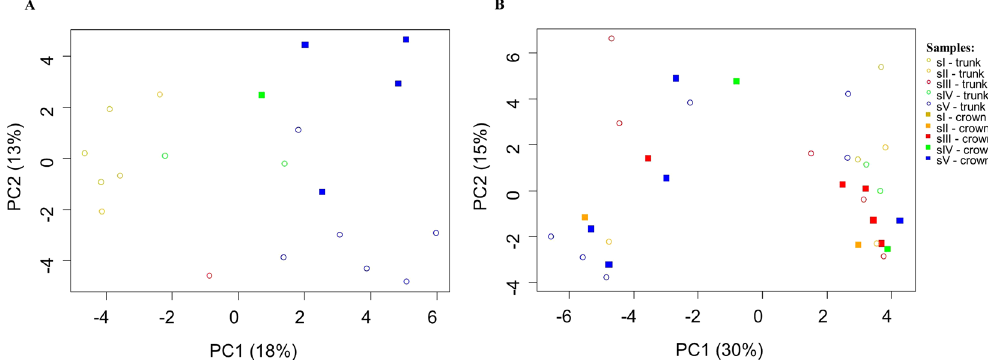
Figure 1. Principal component analysis (PCA) of DGGE fingerprinting of endophytic, wood colonizing bacterial communities from all pine wood tree samples from the two sampling sites obtained after PCR amplification of 16S rRNA gene fragments. The samples grouped according to the different symptomatic physiological classes in Malhada site ( A ); no clear clustering was observed in Avô site ( B